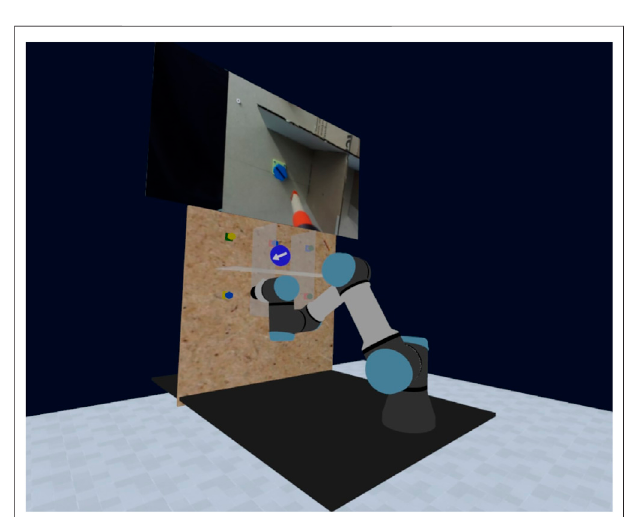
FIGURE 6 | Final virtual reality interface bears similarity with the most popular “ Model + Compass ” prototype, except for two adjustments. First, the image displayed above the model now portrays the view captured from a mounted end effector camera. Second, the compass scaling in size has been adjusted according to user